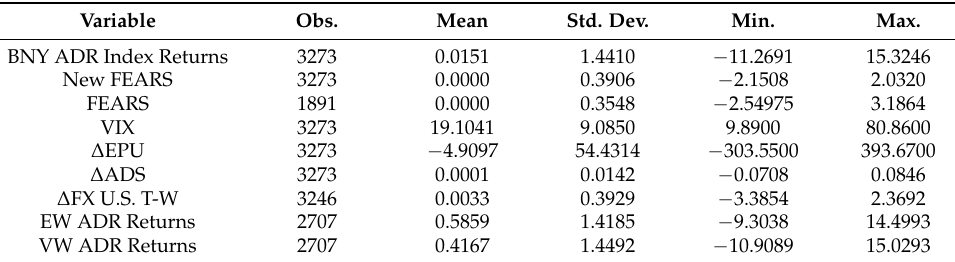
Table 2. Summary statistics.